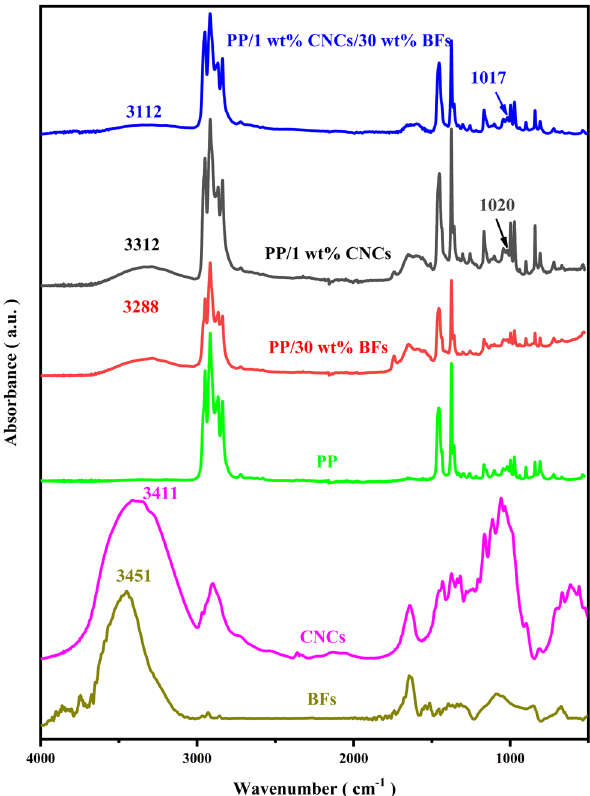
Figure 3: ATR spectra of composites with di ff erent component